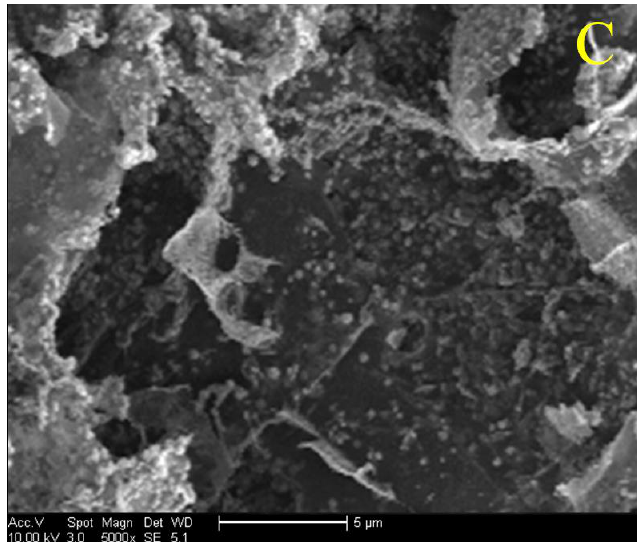
Figure 3. Photo of layered scaffold with designated compositions ( A ) the thickness for chondral layer, mimetic calcified layer and bony layer is about 1.8 mm, 0.6 mm and 1.2 mm, respectively; SEM image taken from the vertical section of layered scaffold ( B ) yellow dashed lines in the image indicate interface between different layers; and, SEM image with high magnification for the site located in bony layer ( C ) of layered scaffold.